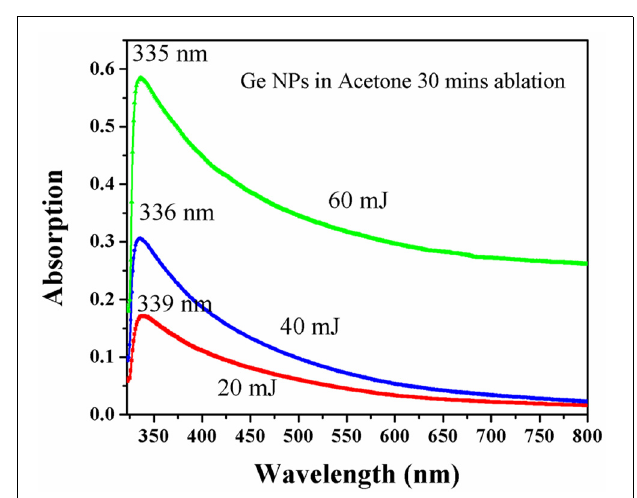
FIGURE 7 | UV Visible absorption spectra of the various laser pulse energy synthesized Ge NPs in